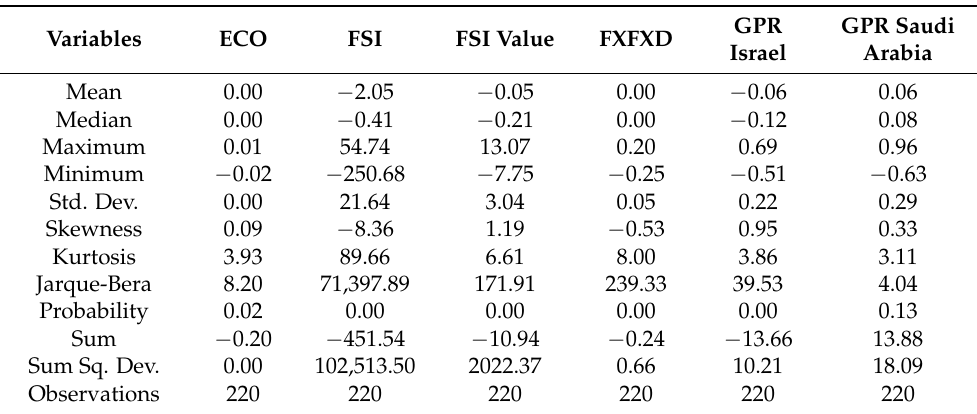
Table 3. Descriptive